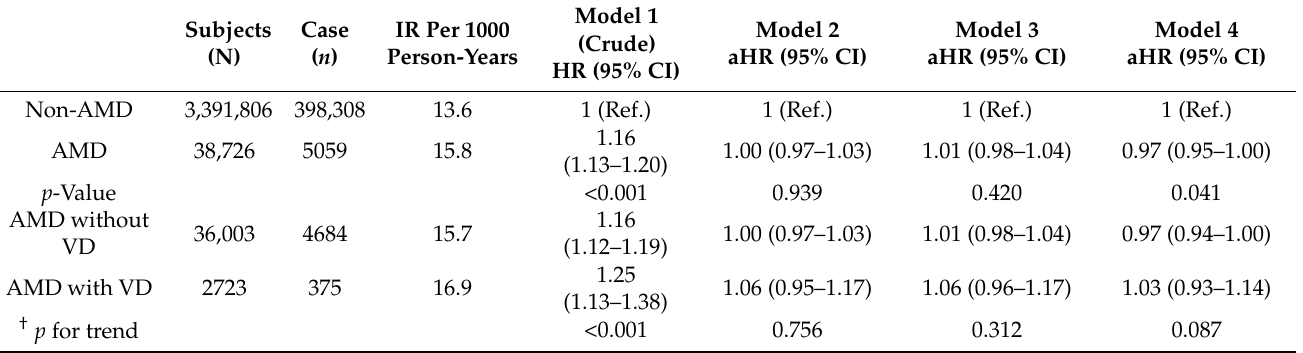
Table 2. Association between age-related macular degeneration and the risk of diabetes mellitus according to visual disability